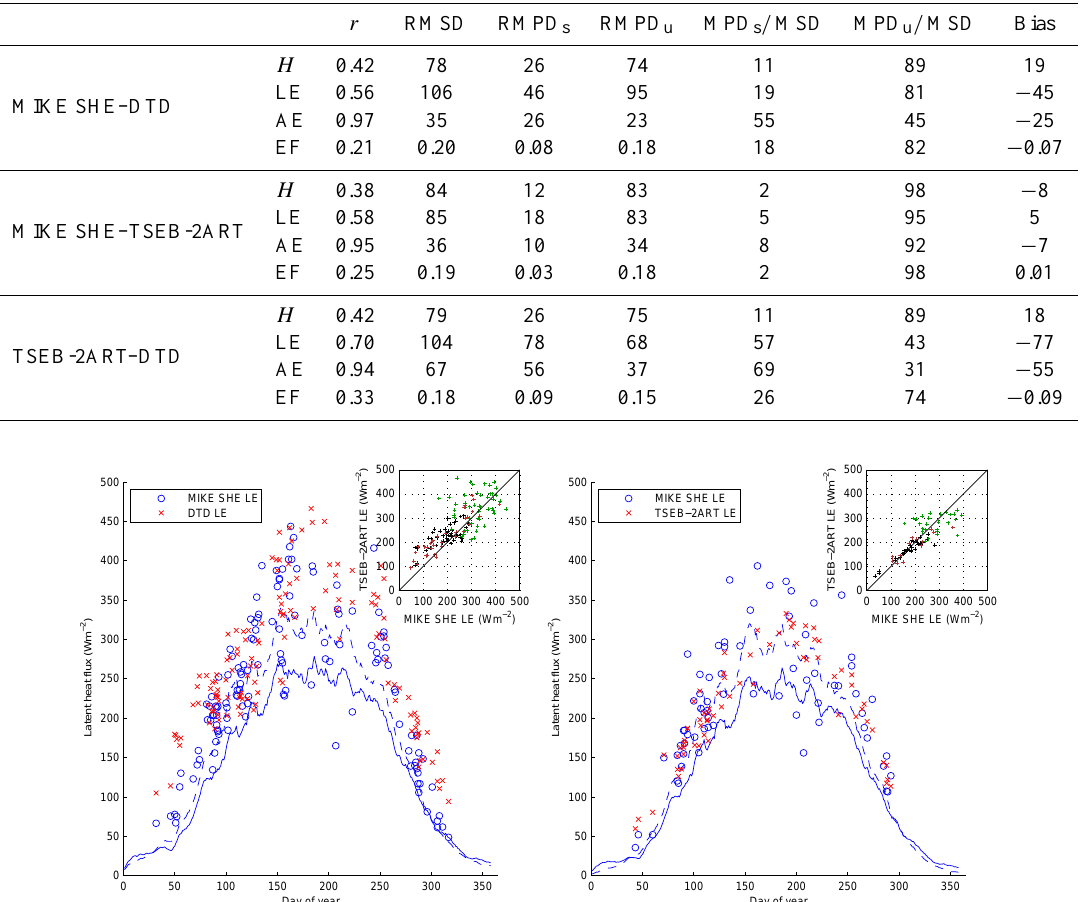
Table 2. Statistical comparison between MIKE SHE, DTD and TSEB-2ART models for sensible and latent heat fluxes ( H and LE), available energy (AE) and evaporative fraction (EF). Statistics used: correlation coefficient ( r ), root mean square difference (RMSD), systematic and unsystematic root mean product differences (RMPD s and RMPD u respectively), the percentage of mean square difference (MSD) attributed to systematic and unsystematic mean product differences (MPD) (MPD s / MSD and MPD u / MSD respectively) and bias. The statistics for H , LE and AE are in Wm − 2 , with the exception of MPD s / MSD and MPD u / MSD, which are percentages. The statistics for EF are unitless, with the exception of MPD s / MSD and MPD u / MSD, which are percentages.